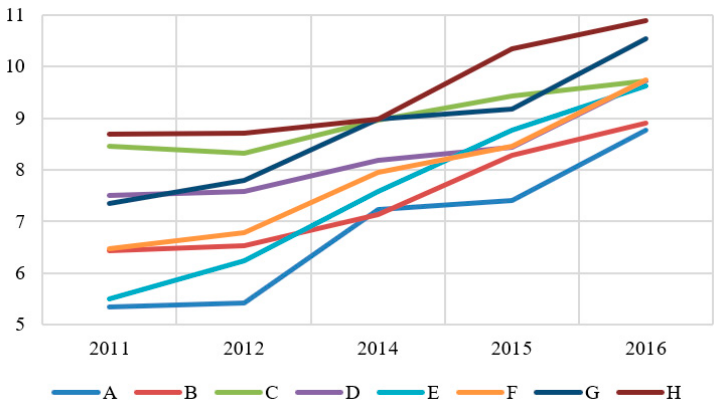
Figure 11. The average number of transport orders per day, received by a forwarder in the Germany-bound transport in the analysed road freight transport enterprises in the years 2011–2016. The analysis of the number of kilometres per one transport order (Figure 12) indicated an average increase of 13% in the discussed